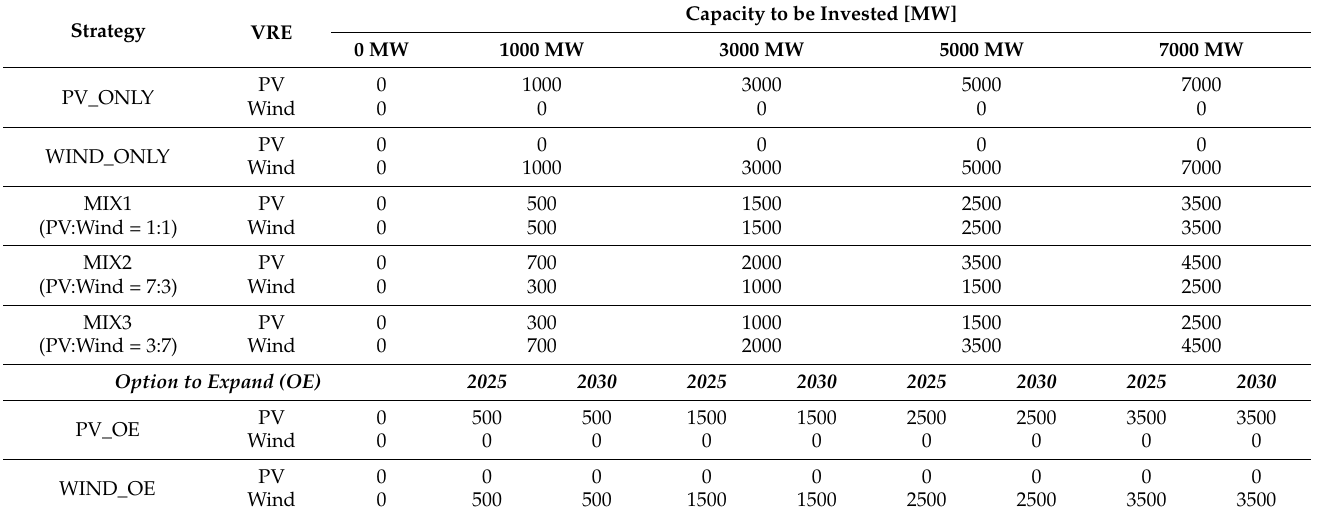
Table 4. Strategies of Company 2 for investment in VRE.